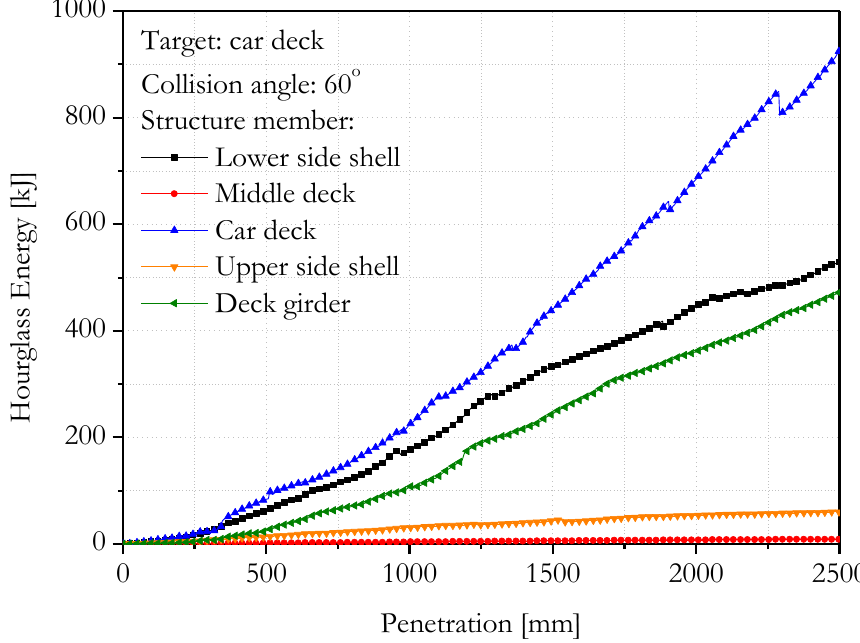
Figure 7. Hourglass energy of the collision angle 60°.